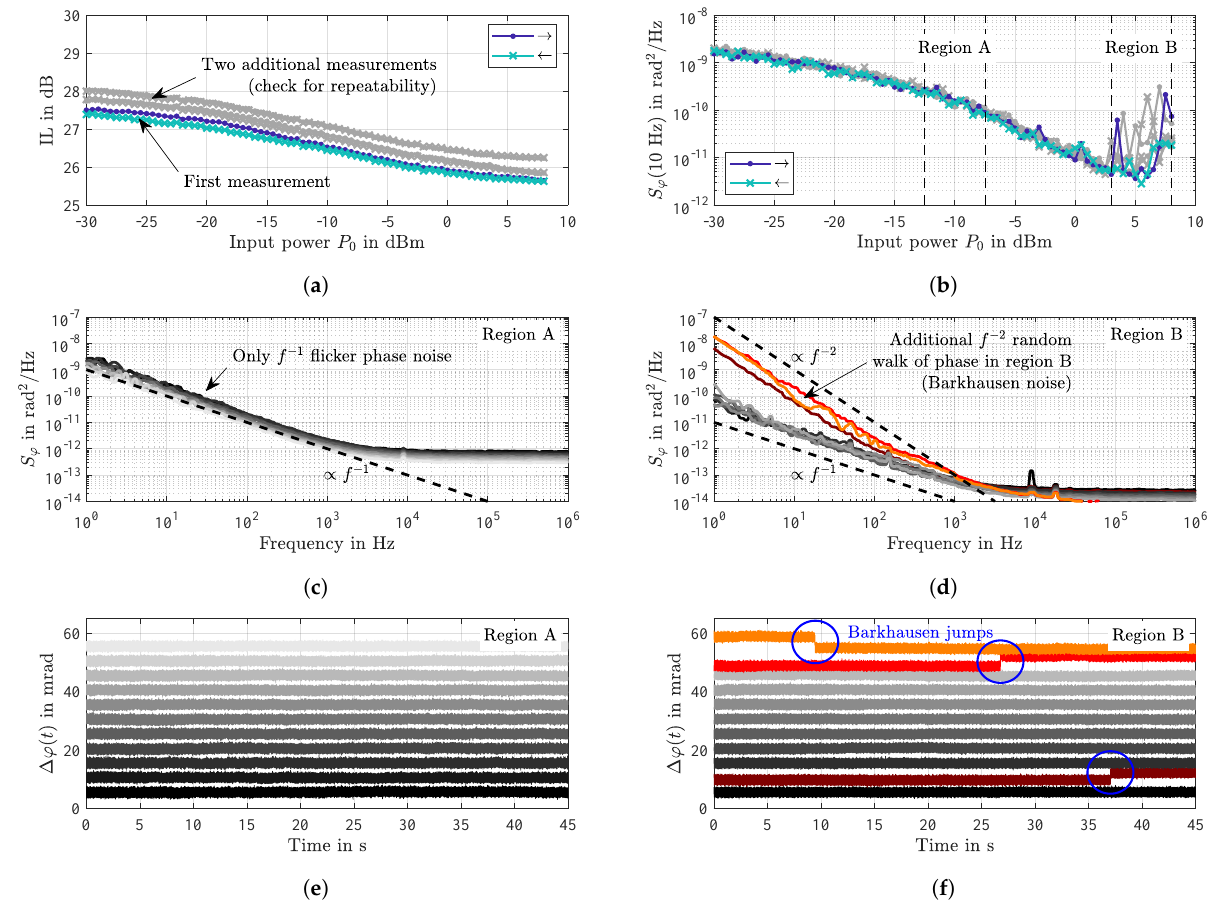
Figure 16. Measured loss and phase noise characteristics as a function of the sensor’s electrical input power P 0 at a constant ambient magnetic bias flux density B bias = 0 (after negative saturation). A direct relation between (hysteresis) losses ( a ) and phase noise at an exemplary frequency of 10Hz ( b ) is revealed for input power levels P 0 approx. below 4dBm. In this regime, i.e., in region A , the power spectral densities of random phase fluctuations progress proportionally to 1/ f ( c ). At higher power levels, i.e., in region B , random walk of phase (1/ f 2 ) occurs ( d ) that is caused by Barkhausen jumps ( f ) that do not occur at lower power levels ( e ). Please note the artificial phase offsets for clearer illustration in ( e , f